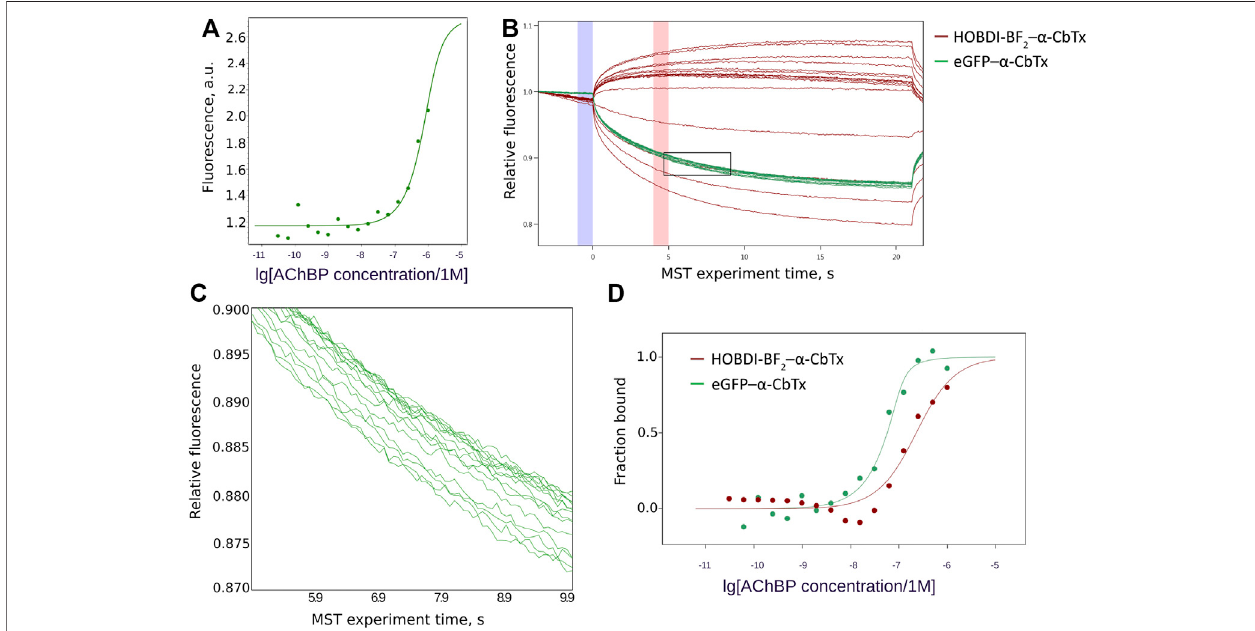
FIGURE 5 | HOBDI-BF 2 – α -CbTx and eGFP – α -CbTx binding to L. stagnalis AChBP. (A) Changes in initial fl uorescence intensity of HOBDI-BF 2 – α -CbTx dependent on AChBPconcentration. (B) MSTtracesshowingthechangeof fl uorescenceovertimeduringtheMSTexperiment.ForbothHOBDI-BF 2 – α -CbTx(red)andeGFP – α -CbTx(green)a setofMSTcurveswasobtained,eachrepresentingasingleMSTmeasurementforeveryconcentrationof L.stagnalis AChBP.Bindingcurveswerecalculatedfrom fl uorescence valuesat5 s(redcolumnonthegraph)correctedfor fl uorescenceat0timepoint(bluecolumnonthegraph).TheregionofeGFP – α -CbTxcurvesenclosedbyarectangleis shown enlarged in the next panel. (C) Enlarged region of eGFP – α -CbTx MST traces showing the signal dependence on AChBP concentration. (D) Binding curves of eGFP – α - CbTx (70 nM) and